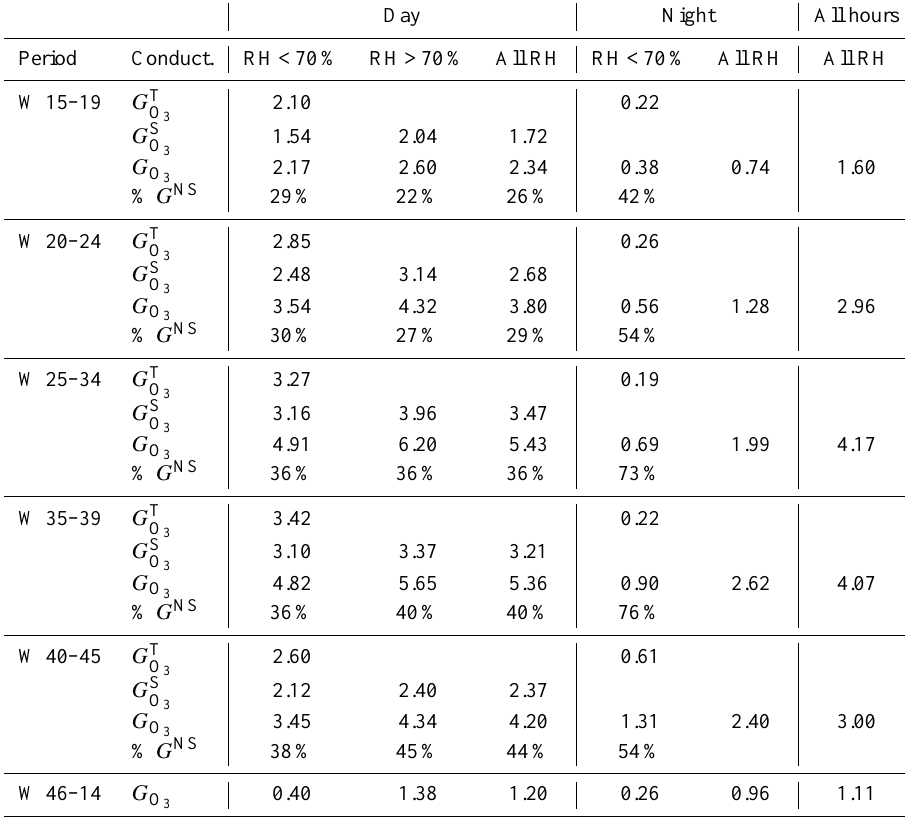
Table 1. Average values of ozone conductances (mms − 1 ) as classified according to the relative humidity, time of day and season. The non-stomatal conductance is given as a fraction (%) of the total conductance. W denotes week, RH relative humidity, G O conductance, and G S and G T the stomatal conductances as inferred from the optimal stomatal model and the canopy level transpiration O 3 O 3 fluxes, respectively. Day Night All hours Period